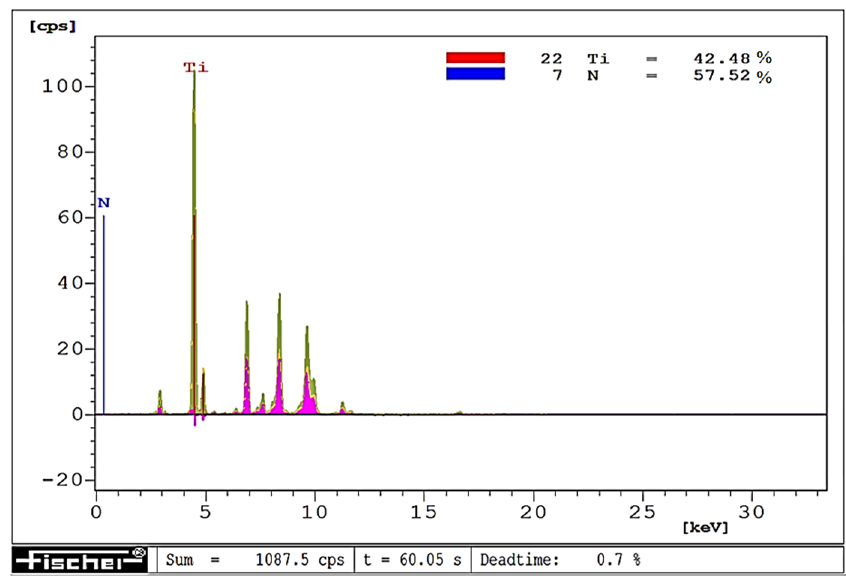
Figure 18. EDXRF image of a TiN coating after heating with 50% of maximum laser power. Before laser heating, the TiN coatings were light yellow. After heating with 40% of the maximum laser power, their color changed to golden, whereas, after heating with 50% of the maximum laser power, the color became darker (golden brown). The color changes observed for the TiN coatings were confirmed by chemical microanalysis results [6,47–50]. Figure 19 shows images of the surface of the test samples before (a) and after laser heating with (b) 40% and (c) 50% of the maximum laser power.